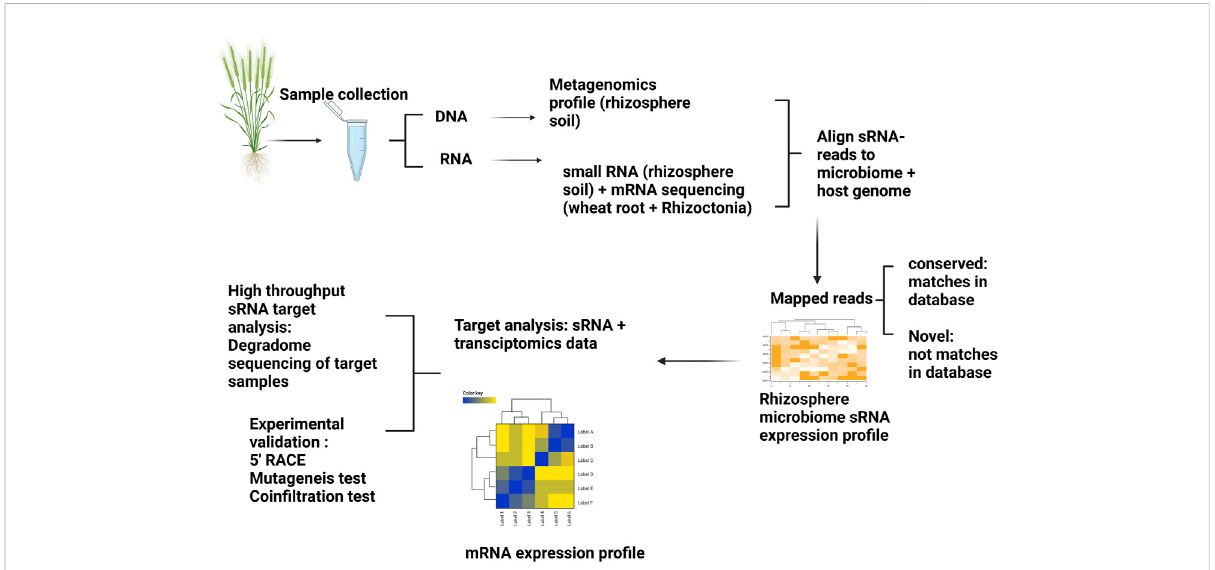
FIGURE 3 Method to study interkingdom signalling mediated by sRNAs in a wheat-rhizoctonia-rhizosphere system. At least three different types of sequencingapproachesarerequiredtotesttheproposedhypothesis:PlanthostsRNAsthatregulatetheactivityofbacterialandfungalgenes,Fungal sRNAsthatmediatetheregulationofplantandbacterialmRNAs,andBacterialsRNAsmediatethesilencingofplantandfungalmRNAs.Metagenomic pro fi ling (to characterize microbiome properties within suppressive and non-suppressive soils), small RNA sequencing (to establish the source andsRNAexpression pro fi lesinthese twosoils),andhost + Rhizoctonia transcriptomicsdata(to compare thedifferentialexpressed genesidenti fi ed as potential sRNA targets).In thisexample, we hypothesise that sRNAs originating in the rhizosphere microbiome may cross to plant tissues, thereby silencing plant genes. Therefore, we would expect sRNA expression pro fi les to bedifferentin SP and NSP communitieswith corresponding changes to the transcriptomic pro fi les of wheat genes. Once the sRNA:mRNA pair predictions are made, validation of these target pairs using different molecular tools such as degradome sequencing, 5 ′ RACE, mutagenesis tests, and transient co-expression tests can be